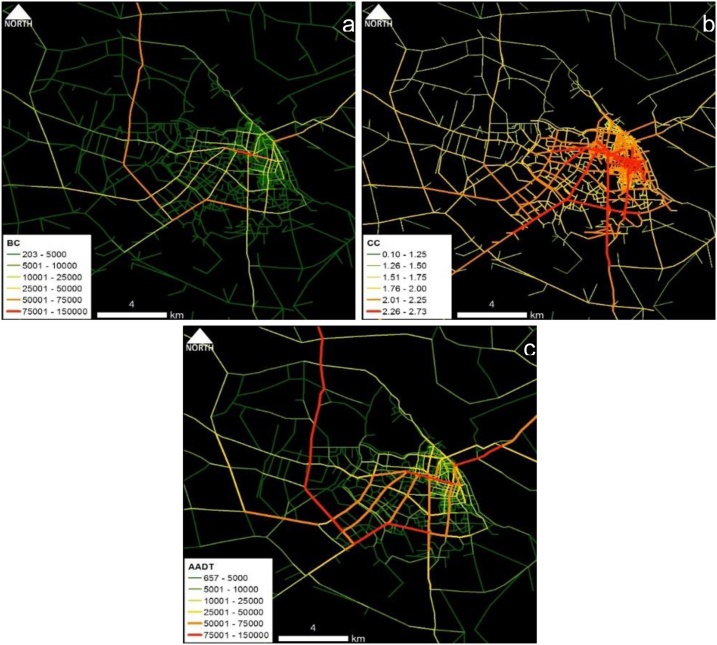
Phnom Penh case study area: Spatial distribution of (a) BC(PD) and (b) CC(PD) and (c) estimated AADT.